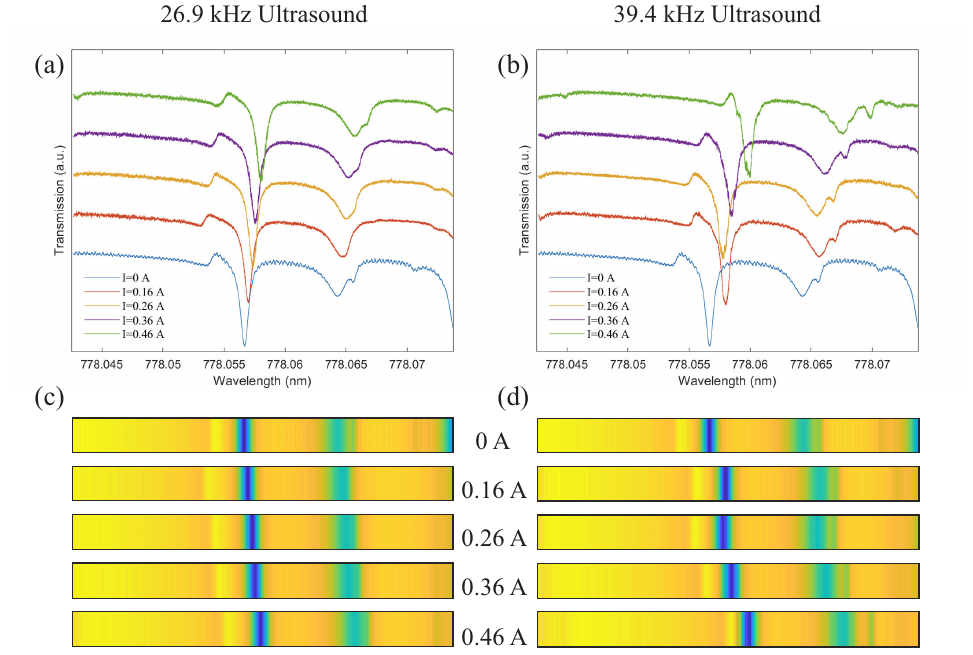
Figure 4. Variation trend of mode i with ultrasound. ( a ) The response of mode i to the 26.9 kHz ultrasound. ( b ) The response of mode i to the 39.4 kHz ultrasound. ( c ) Optical barcode corresponding to ( a ). ( d ) Optical barcode corresponding to ( b